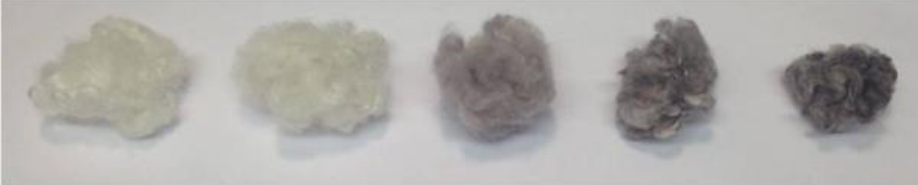
Figure 8. Photograph of impregnated silks, from left to right : native silk, control impregnation (no scCO 2 ), scCO 2 impregnation 0.1, 0.3, and 0.6 O.D, respectively. scCO 2 ), scCO 2 impregnation 0.1, 0.3, and 0.6 O.D, respectively.